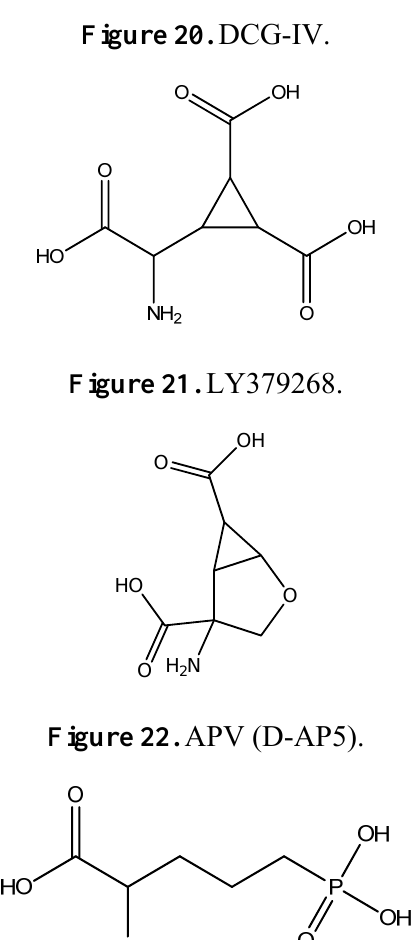
Figure 20. DCG-IV.